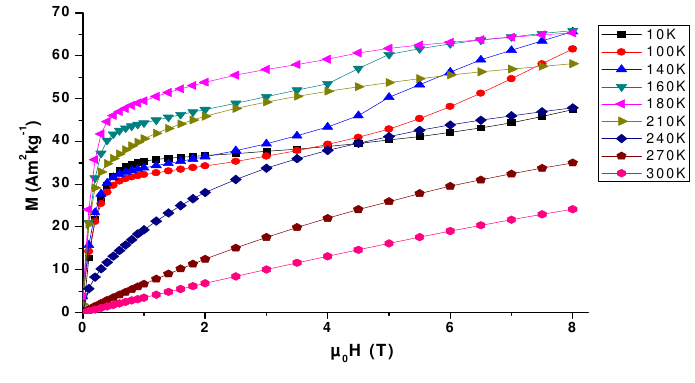
Fig.4 : M (H) curves at several temperatures for La